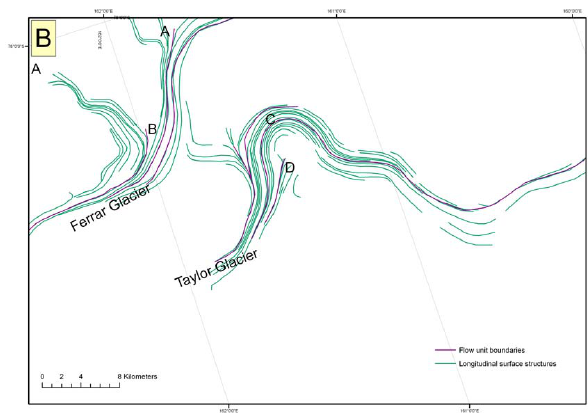
Fig. 3a. Portion of LIMA Landsat image LE705911 showing Taylor and Ferrar Glaciers in the Ross Sea area of Antarctica.